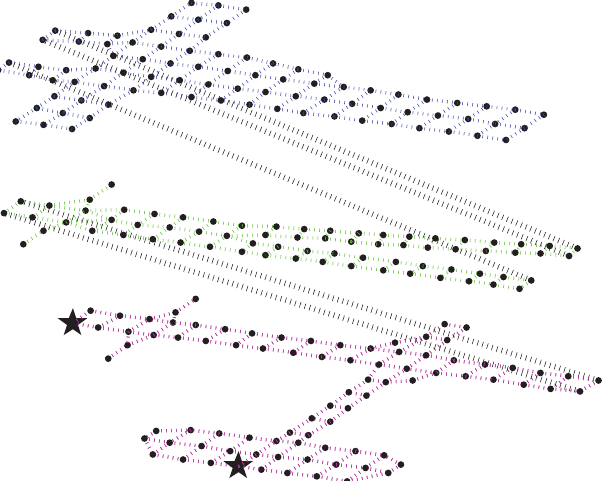
Figure 2. Graph representation of the building model. The two black stars on the ground floor mark the position of the building’s